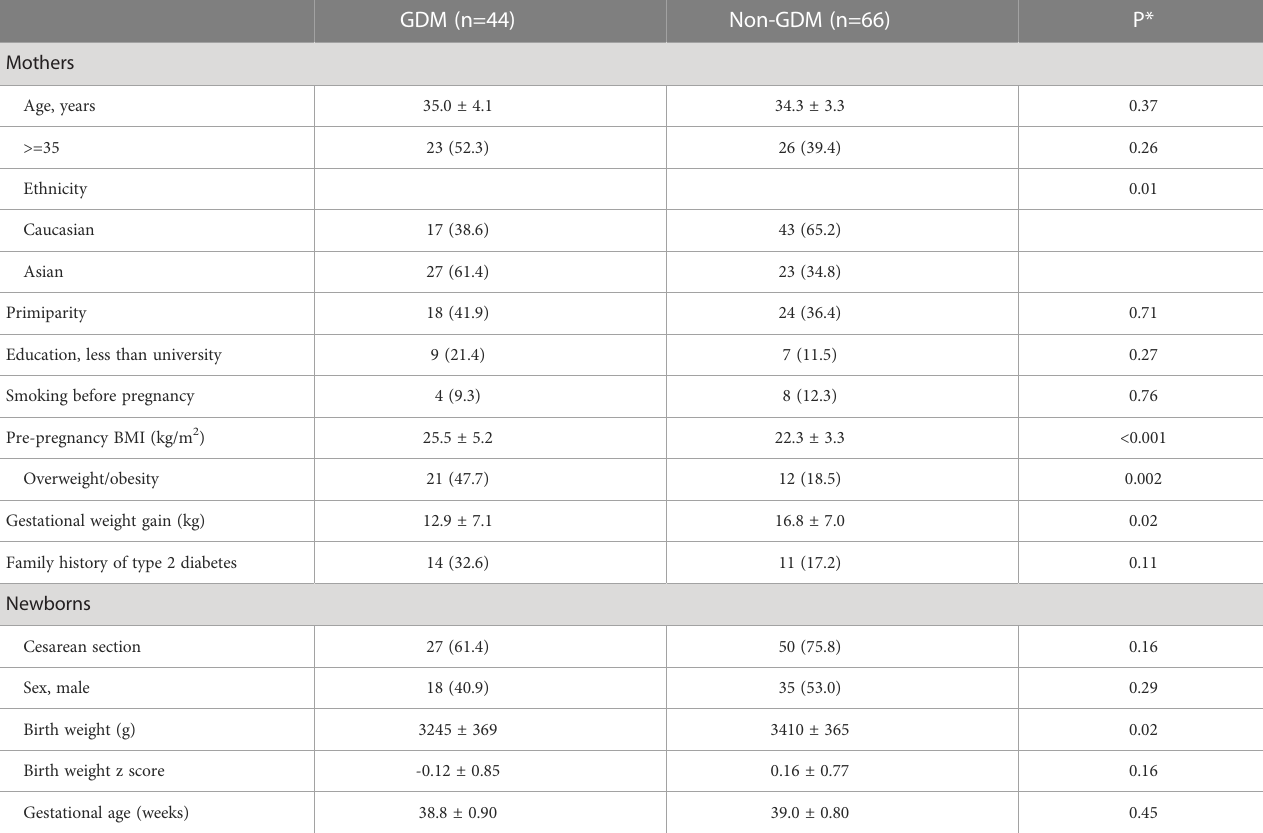
TABLE 2 Characteristics of mothers and newborns by GDM status